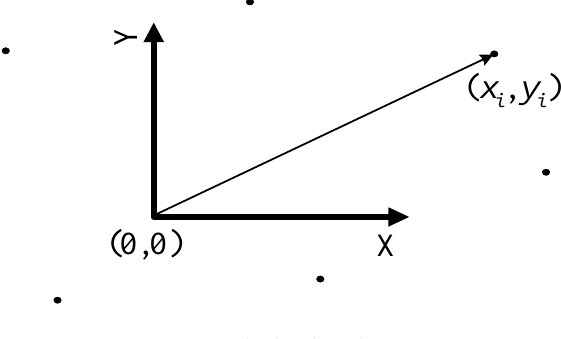
Figure 3. The landmark map.